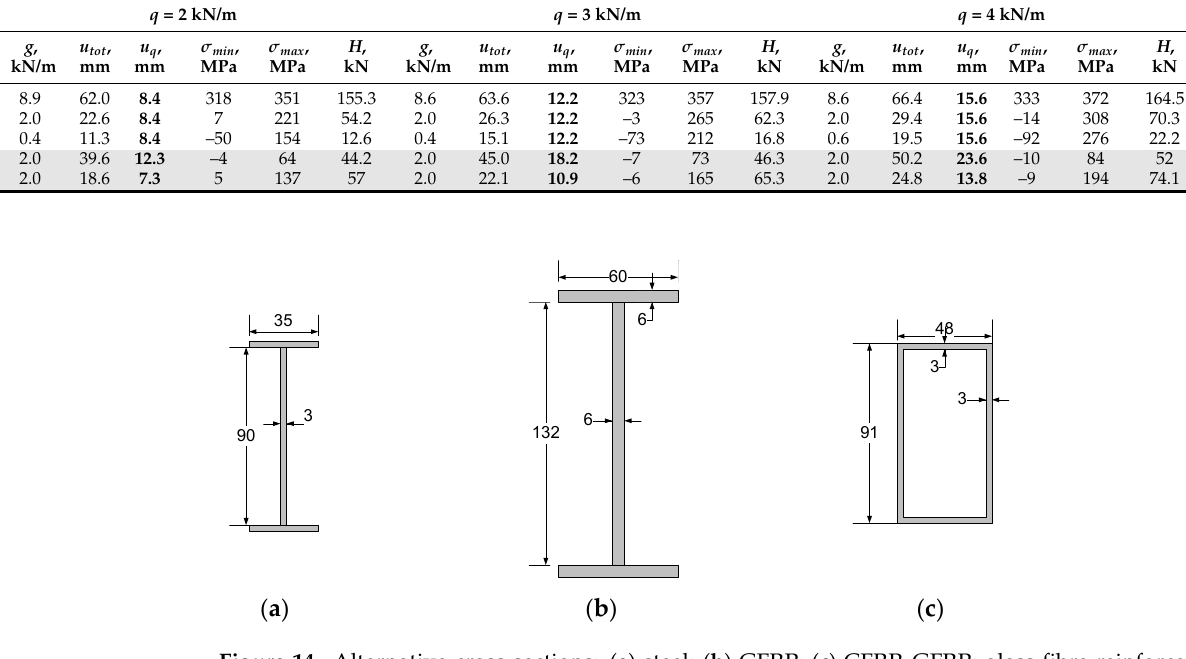
Figure 14. Alternative cross-sections: ( a ) steel; ( b ) GFRP; ( c ) CFRP. GFRP: glass fibre-reinforced polymer; CFRP: carbon fibre-reinforced polymer. Table 4. Physical properties of alternative stress-ribbons.